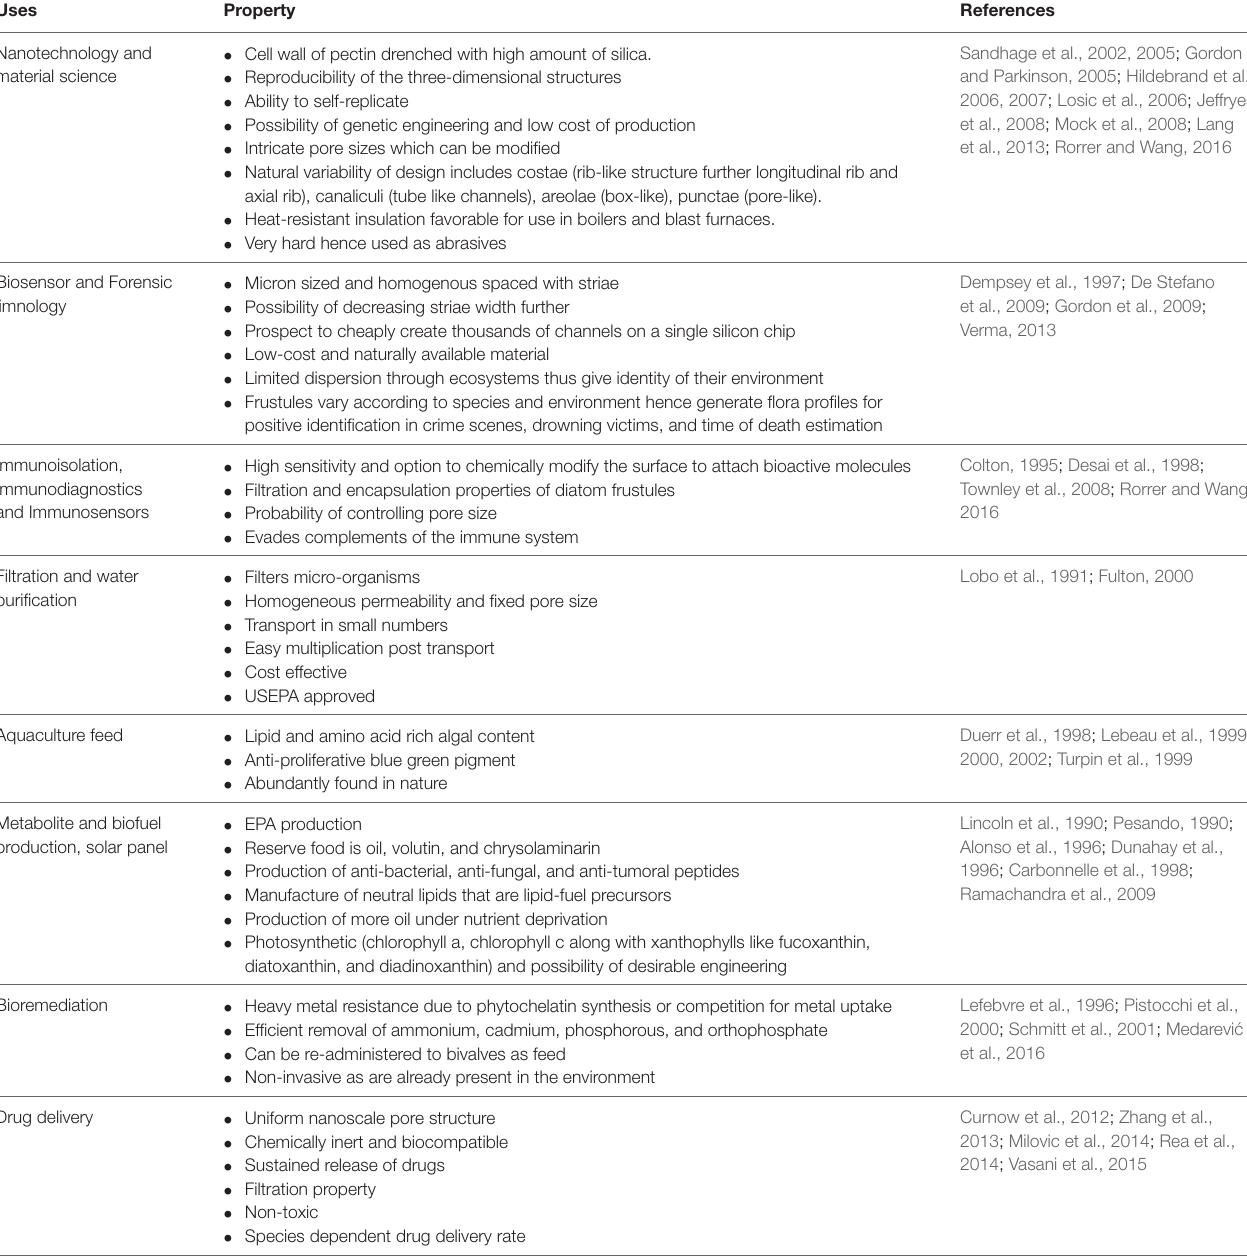
TABLE 1 | Properties of diatoms which make them suitable for various uses.